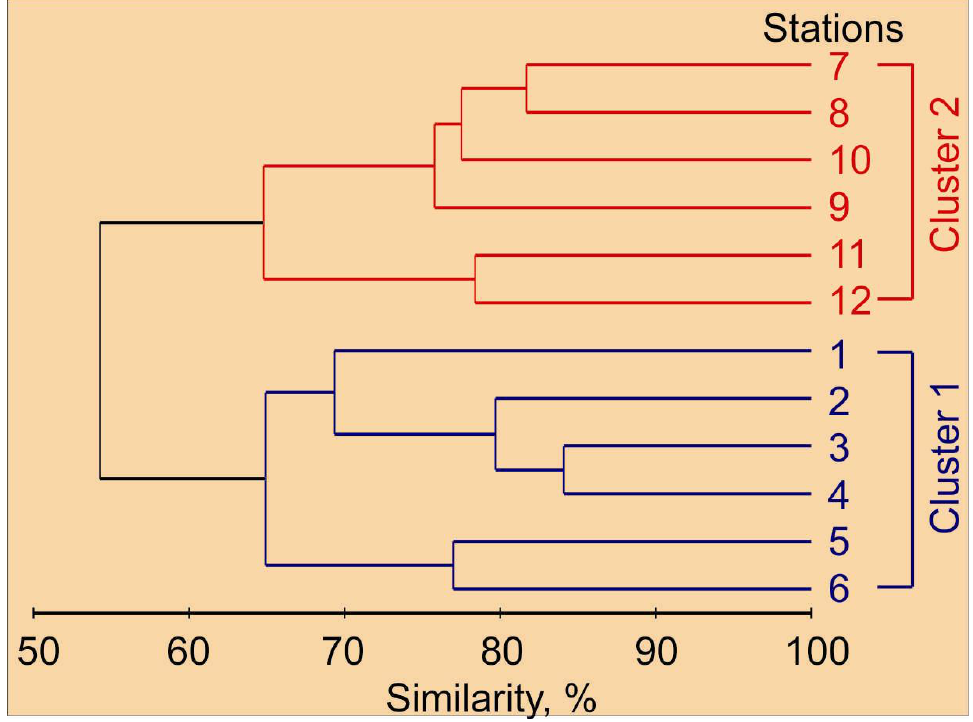
Figure 3. Percent similarity cluster dendrogram of mesozooplankton abundance (individuals m − 2 ) in the eastern Barents Sea in May 2016.